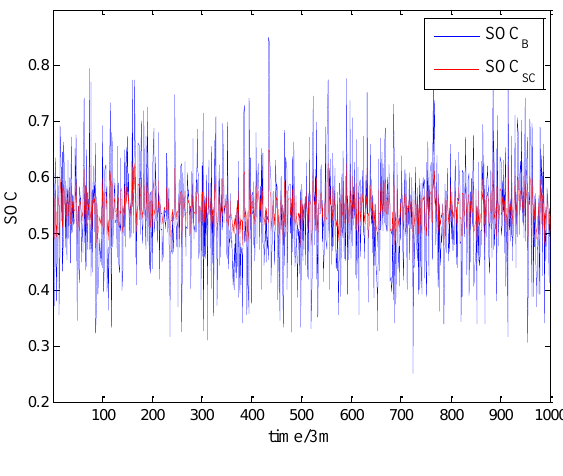
Figure 7. SOC of the ESS.